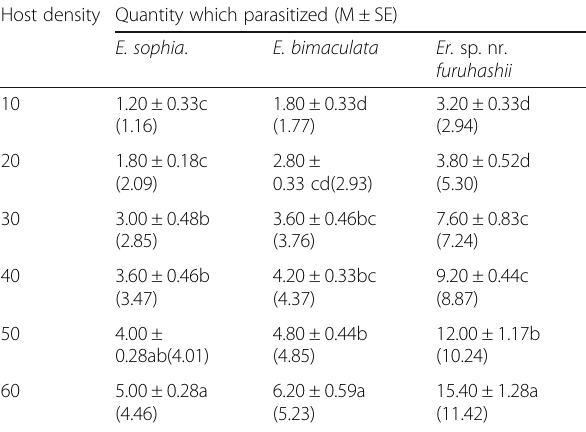
Table 2 Parasitic function of parasitoid in different density Bemisia tabaci